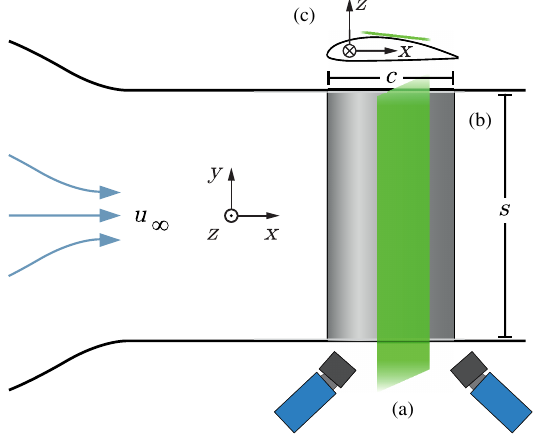
FIG. 1. (a) Photograph of a LSB on airfoil CK220. The laser light sheet illuminates the particle-seeded inflow from the right- hand side and perpendicular to the airfoil ’ s surface, resulting in a shadow at the leading edge. The inflow is coming from the left-hand side. The LSB can be identified as a region without smoke between the airfoil ’ s surface and the ambient flow. False colors are used for better visualization. (b) Labeled zoom, emphasizing the flow topology at the LSB. The LSB occurs just behind the airfoil ’ s thickest cross section, where streamlines (in blue) separate from the surface. Further downstream, when the LSB is at its maximum expansion, the laminar shear layer destabilizes, resulting in transition to turbulence. High momen- tum perpendicular to the airfoil ’ s surface contained in the shear layer enables reattachment and the formation of a turbulent boundary